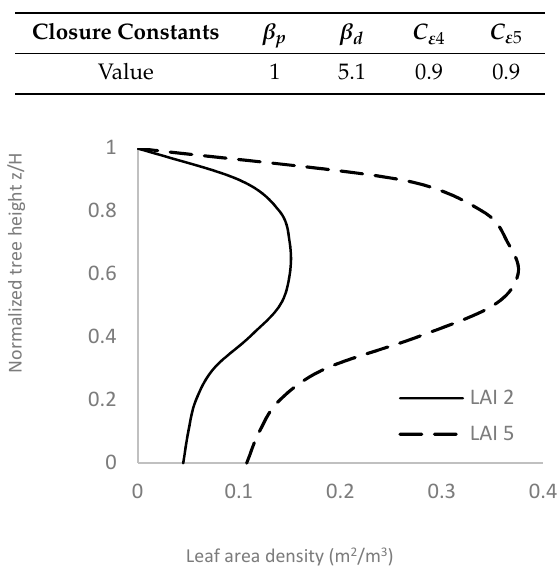
Figure 1. Typical distribution of LAD for a deciduous forest. LAI of 2 and 5 are used in the simulations in this study.